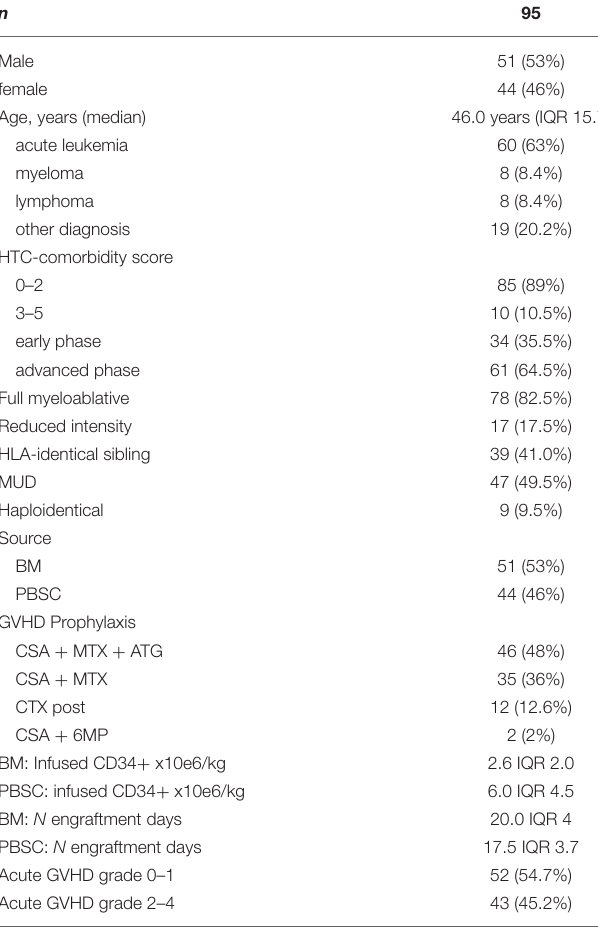
TABLE 1 | Patient demographics and transplant-related features. TABLE 2 | Day + 18 cytokines in plasma according to donor type and to